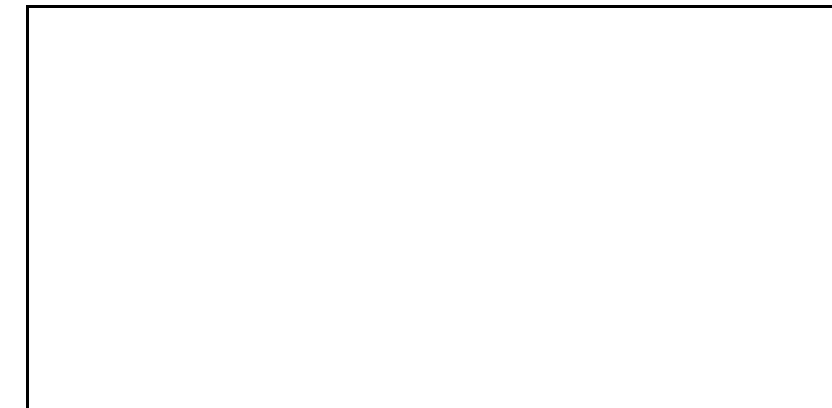
Fig. 2 Questionnaire at the end of the Summer